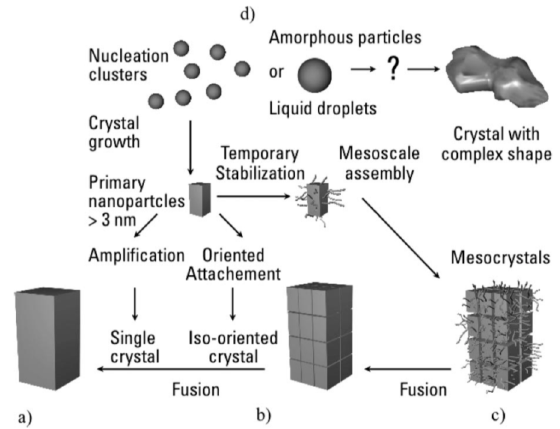
Figure 4. Schematic representation of classical and non-classical theory of crystallization: classical nucleation and crystal growth pathway ( a ); iso-oriented crystal pathway ( b ); mesoscale assembly pathway in the presence of polymer or additive ( c ); and transformation of amorphous precursor particles pathway ( d ) (from [108]. Copyright 2008 John Wiley & Sons. Reproduced with permission).